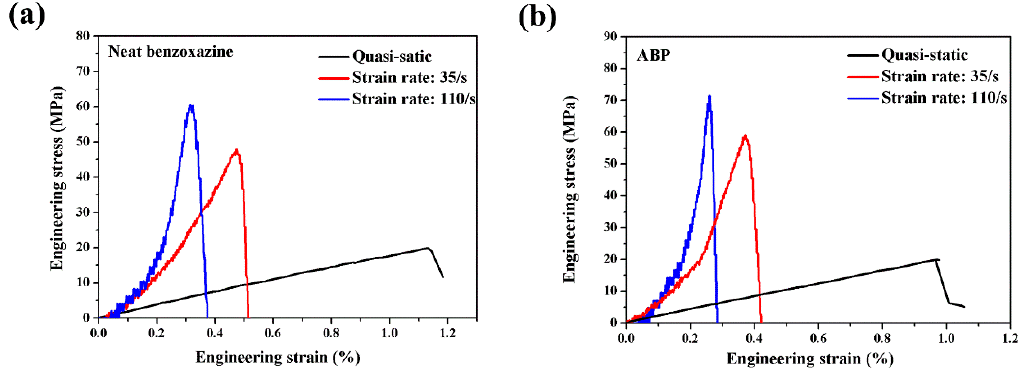
Figure 8. Rate dependence of tensile behavior of neat benzoxazine and its composite. ( a ) Neat benzoxazine, ( b ) ABP.